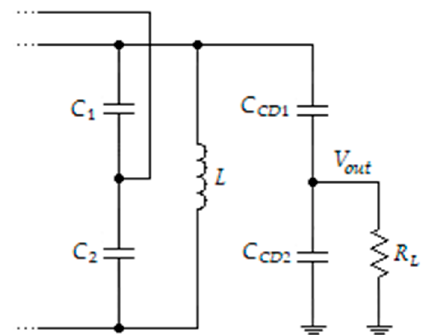
Figure 22. A capacitive divider with load resistance R L at the oscillator output.